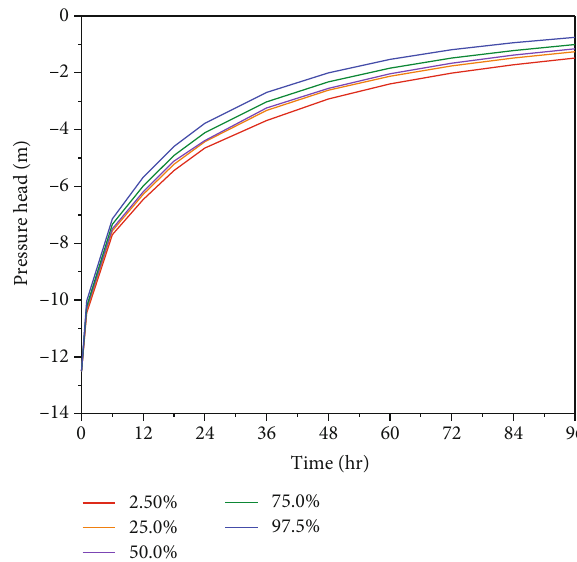
Figure 9: Pressure head at 1m depth of the observation pro fi le with di ff erent percentiles of the